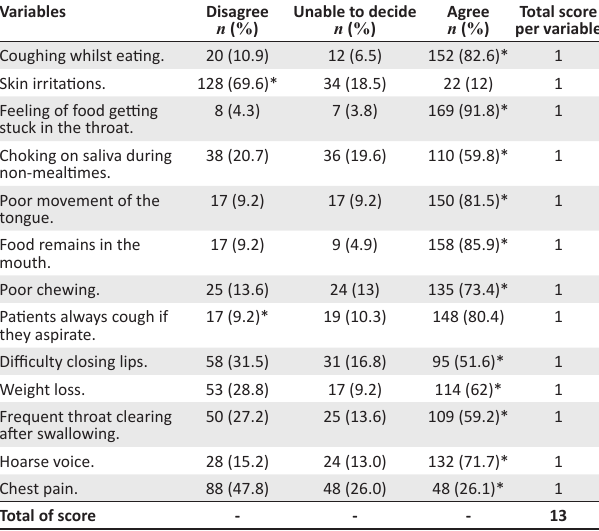
TABLE 2: Participants’ knowledge about the signs and symptoms ( n = 184).